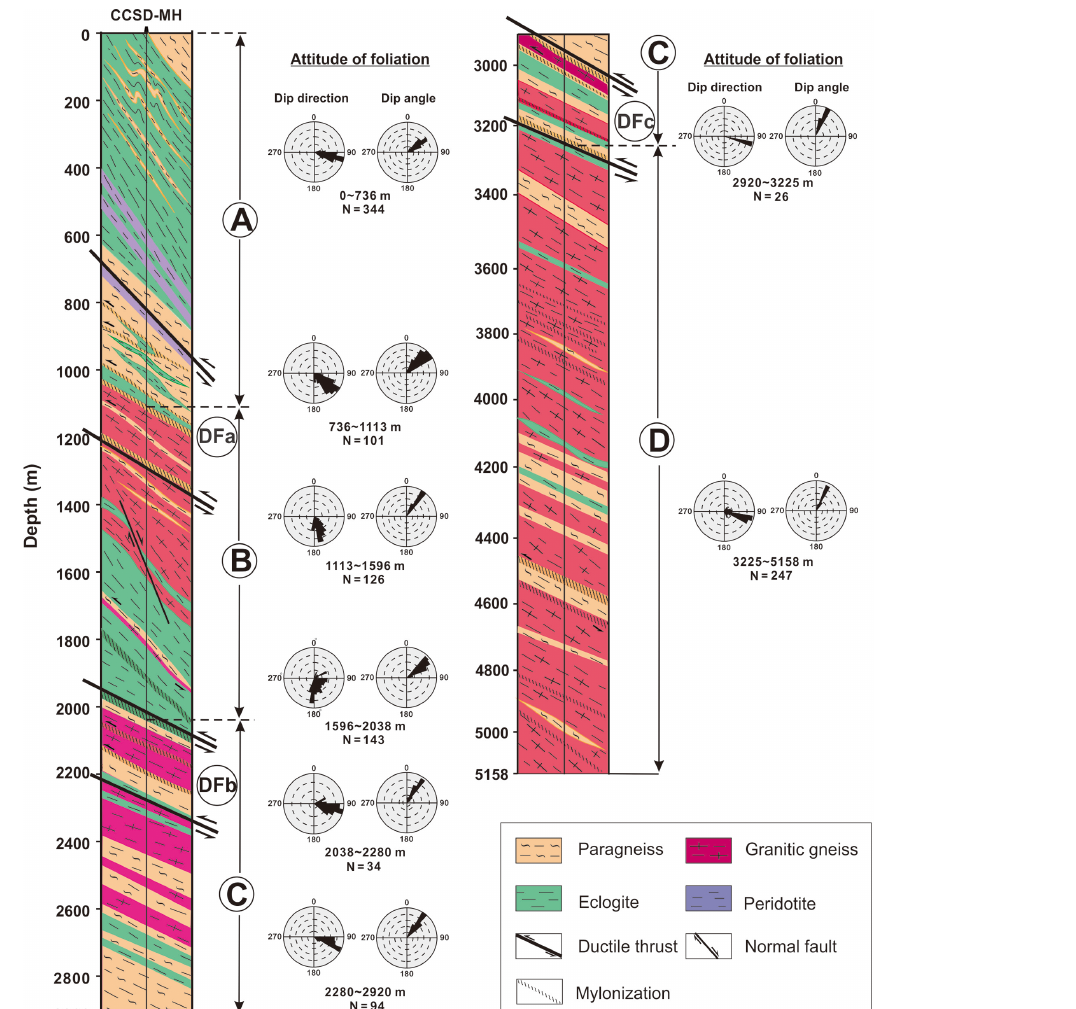
Figure 4. Simplified structural profile of the CCSD-MH in Donghai County (Xu et al., 2009b). The three southeast (SE)-dipping ductile shear zones DFa, DFb, and DFc can be traced to the surface according to seismic reflection